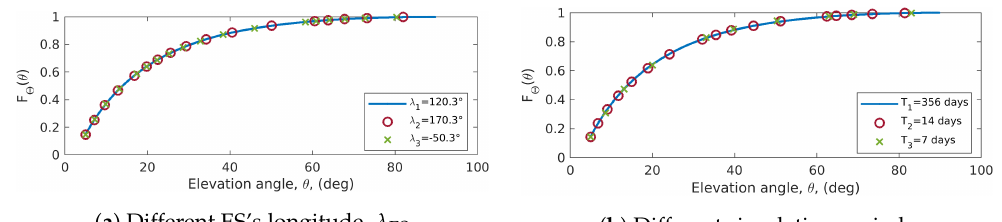
Figure 13. CDF F Θ ( θ ) for the same orbit configuration and ES latitude but for ( a ) different ES longitude and ( b ) different simulation